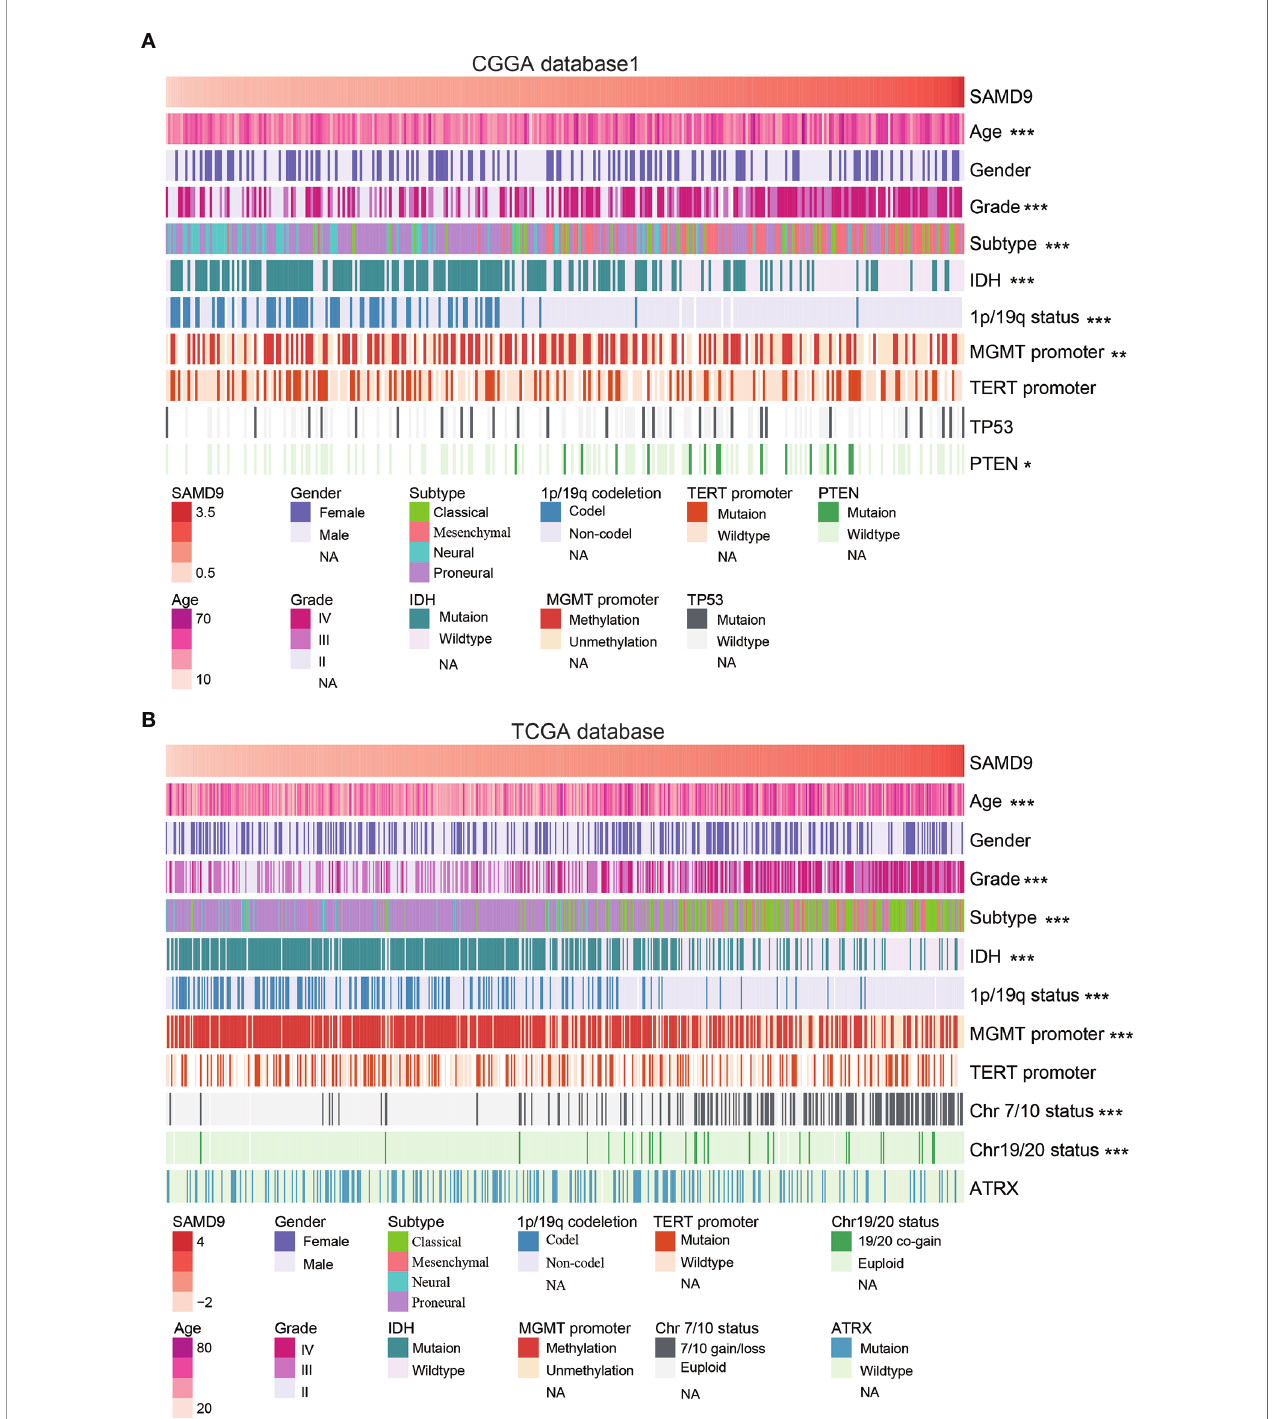
FIGURE 2 | SAMD9 transcription level accompanied with classical genetic alterations and clinical character of glioma. (A) With increasing expression of SAMD9 in CGGA database 1, patients characterized with age group, ***high grade, ***oligodendrocyte and GBM subtype, *** IDH wild type, ***1p/19q intact, ***MGMT promoter unmethylation status, ** PTEN mutation. (B) The correlation of SAMD9 expression level in TCGA database with age group, ***high grade, ***oligodendrocyte and GBM subtype, ***IDH wild type, ***1p/19q intact ***MGMT promoter unmethylation status, ***Chromosome 7/10 Euploid, ***Chromosome 19/20 Euploid, *, **, and *** indicate p < 0.05, p < 0.01, p < 0.001,